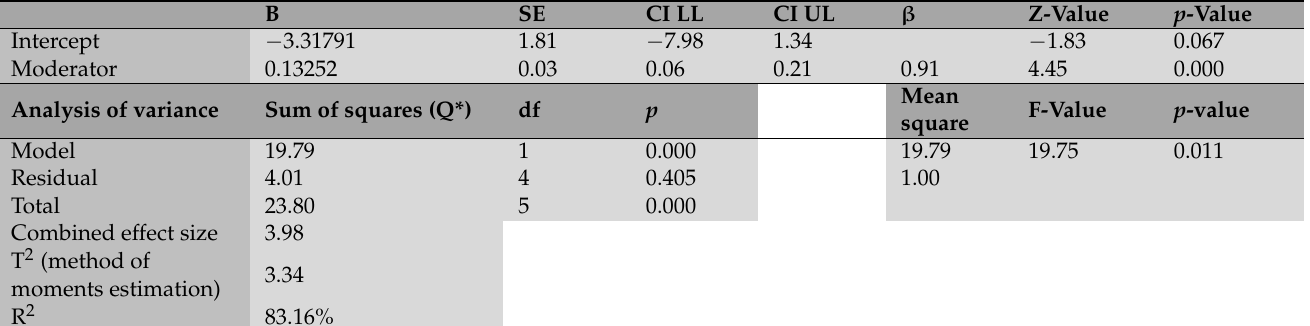
Table 8. Regression of moderator on effect size showing a model y= − 3.31791 + 0.13252x and p <